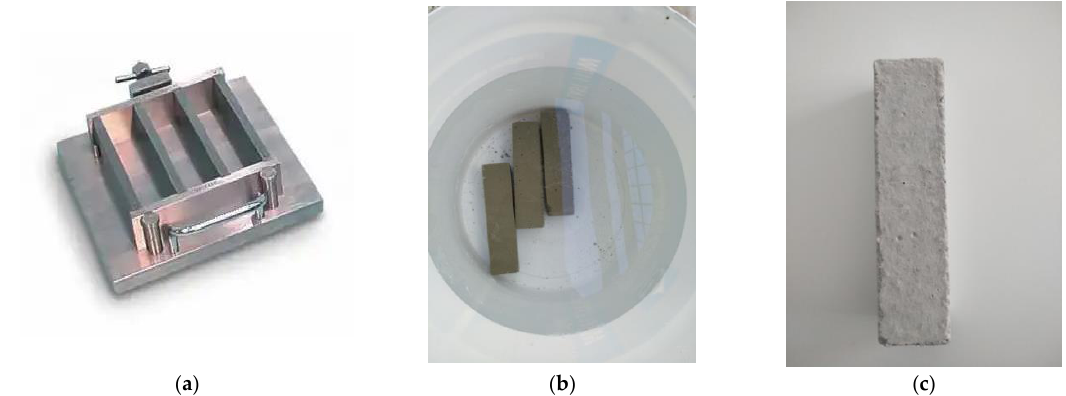
Figure 3. ( a ) Three-gang mold for 40 × 40 × 160 mm cement specimens; ( b ) 28-days hydration of cement specimens; ( c ) cement specimen.